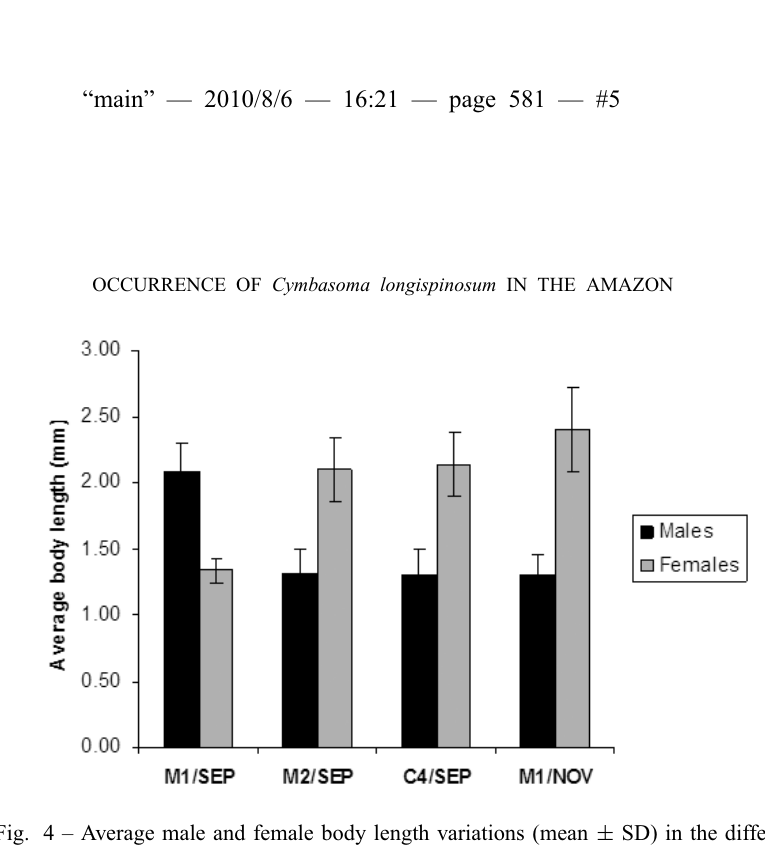
station M1 (Muriá), with a total density of 0.29 org.m − 3